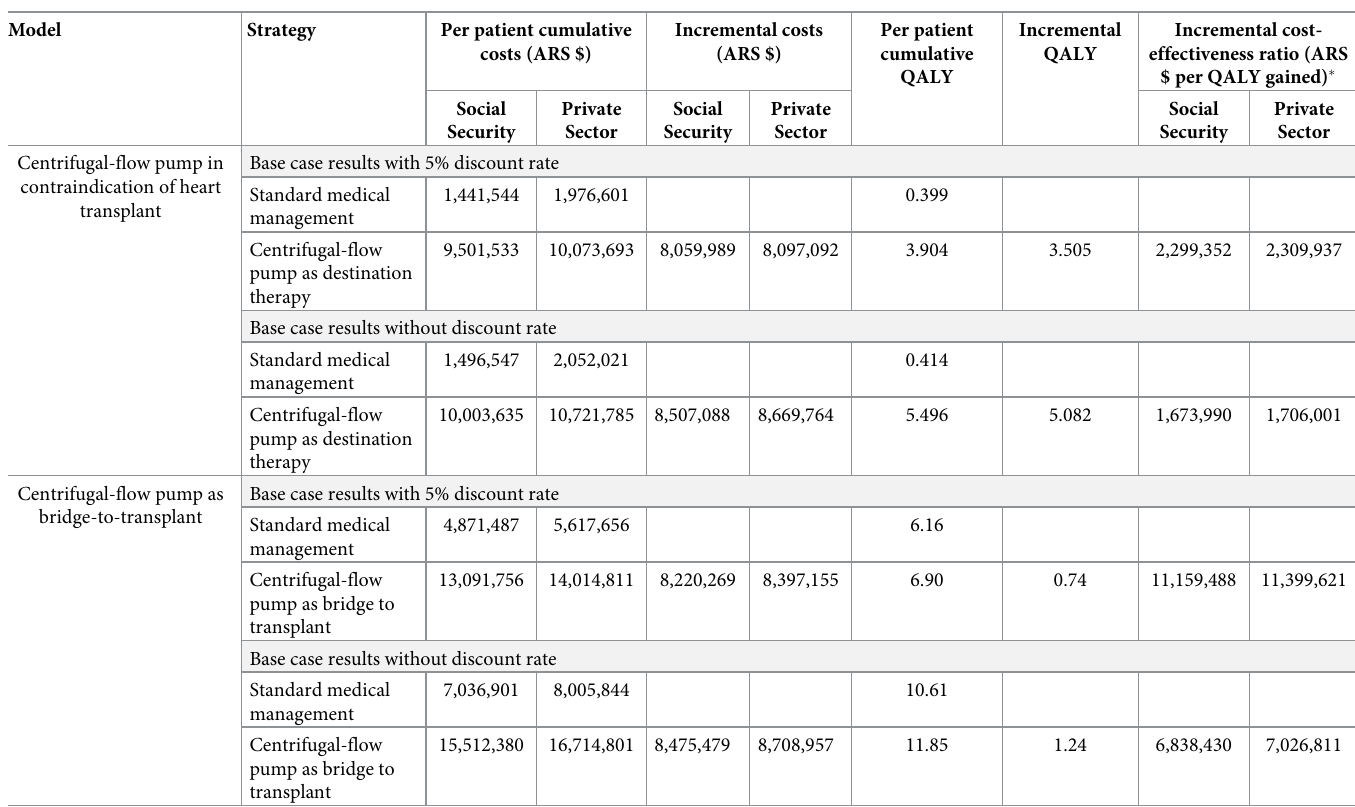
Table 2. Base case